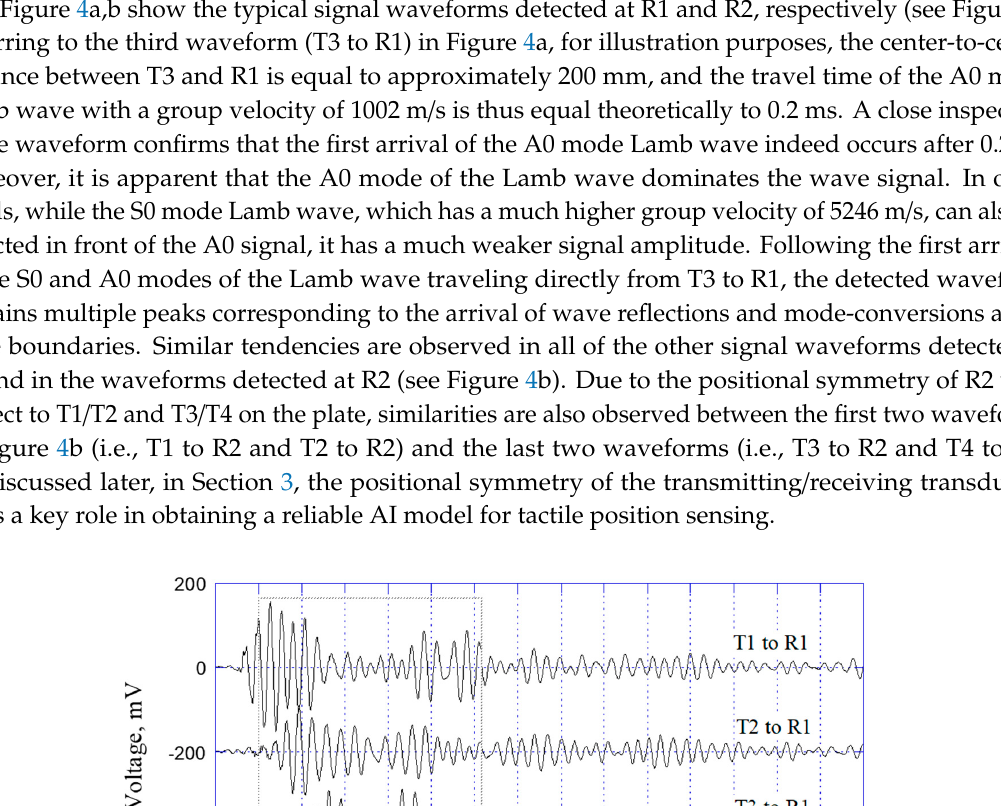
Figure 3. Dispersion curves of A0 and S0 modes of Lamb waves in a 0.8 mm thick stainless steel (SS 304) plate.